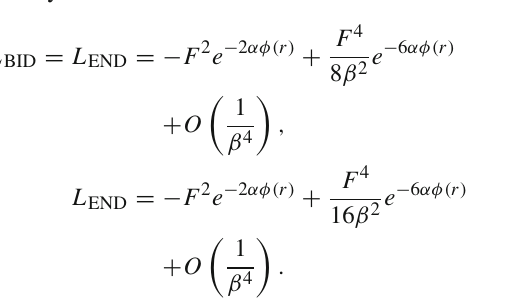
( a ) END black holes (b) LND black holes Fig. 3 Gibbs free energy versus T for β = q = b = k = 1 and α = 0 . 3